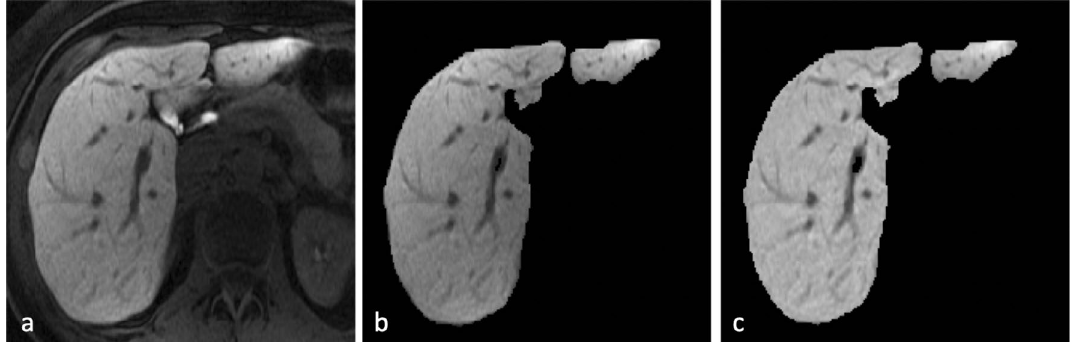
Figure 3. An example of liver MRI preprocessing ( a ) raw image ( b ) liver segmentation ( c ) noise reduction and background inhomogeneity